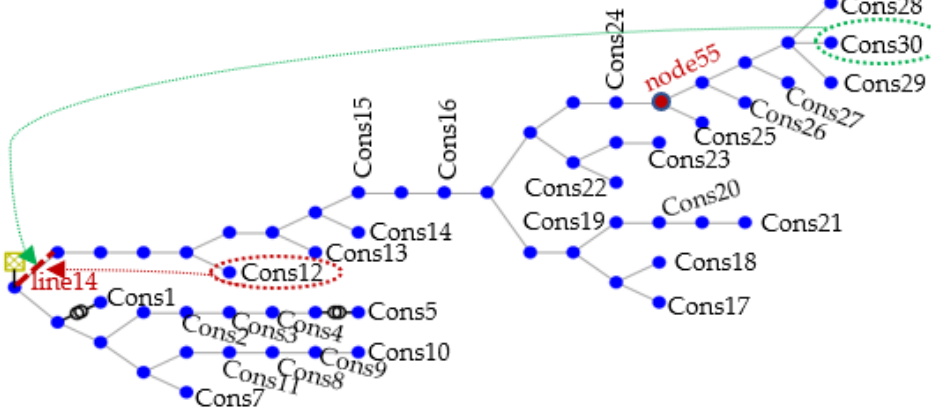
Figure 7. Illustration of the results listed in Table 1.